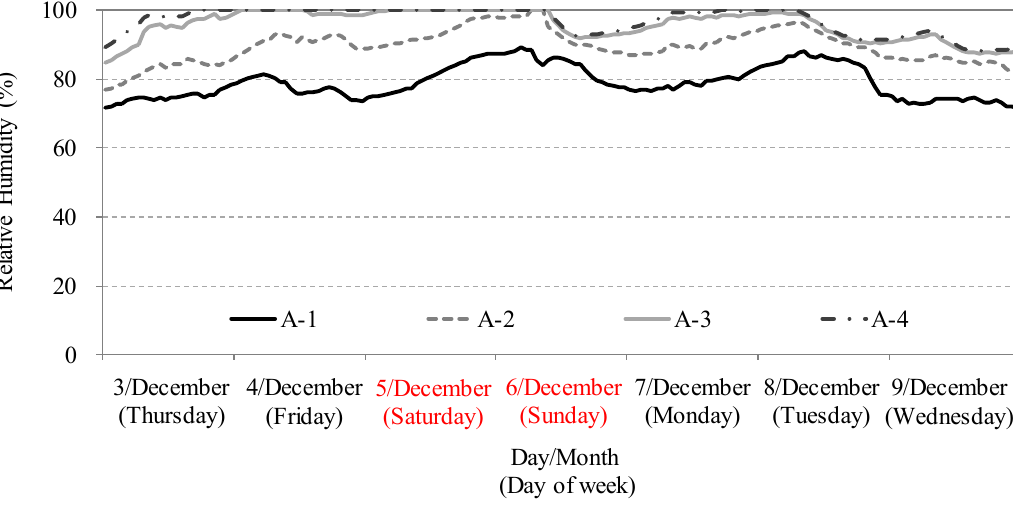
Figure 10. Relative humidity in the sixth floor of the east staircase (3 December–9 December).